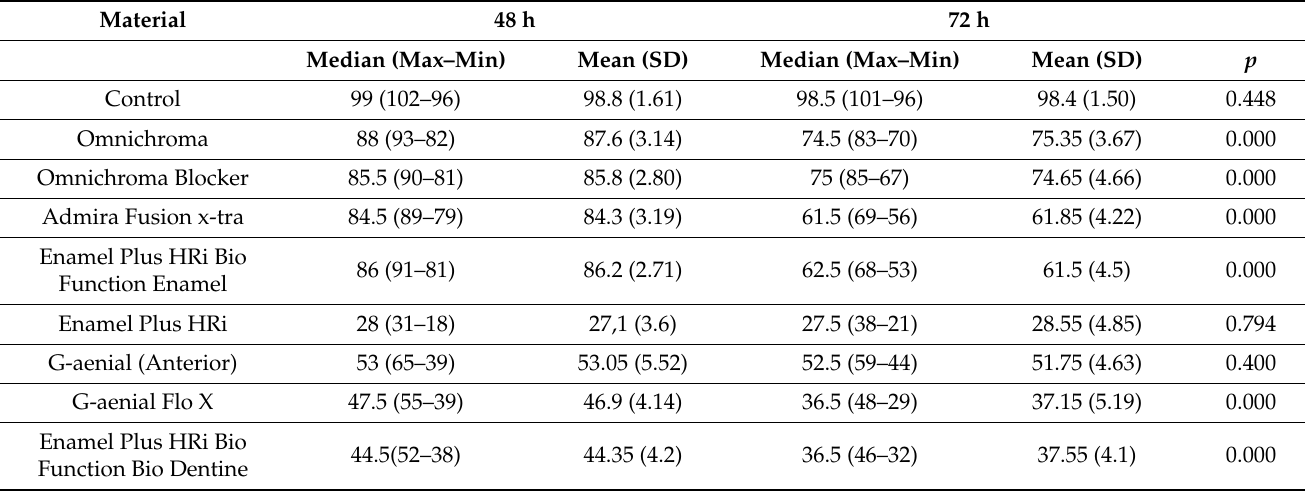
Table 2. Statistical comparisons using Wilcoxon Test for each material after 48 h and 72 h. Significance was set at 0.05.